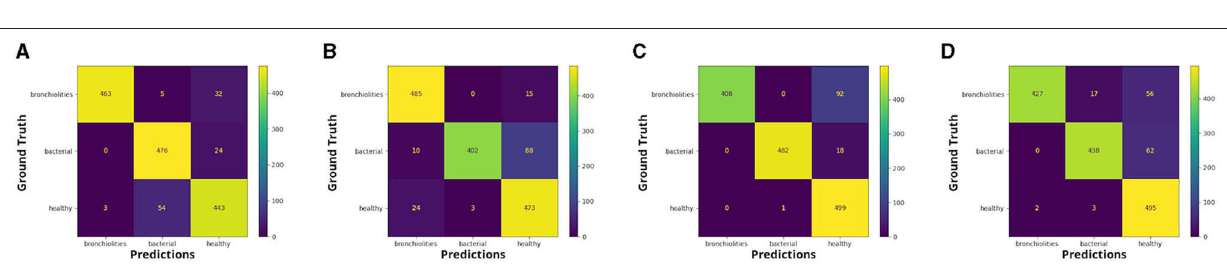
FIGURE 1 | Confusion matrices: healthy vs. bronchiolitis, respectively for (A) fold 1, (B) fold 2, (C) fold 3, and (D) fold 4.